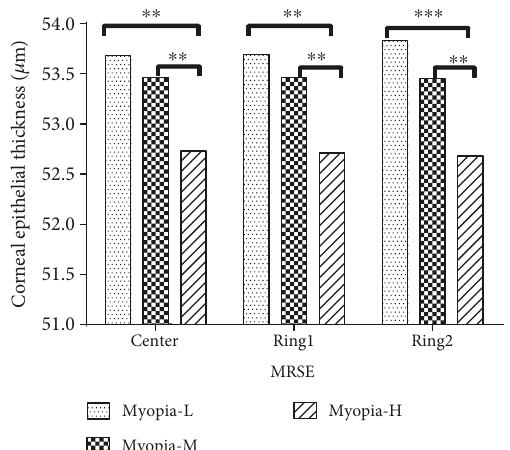
Figure 5: For three locations (center, Ring1, and Ring2), di ff erences of corneal epithelial thickness among di ff erent MRSE groups which were divided according to manifest refraction (group myopia-L for less than or equal to 3.00D, group myopia-M for 3.00D to 6.00 D, group myopia-H for more than 6.00D). ∗∗ and ∗∗∗ indicate P < 0 01 and P < 0 001 , respectively.